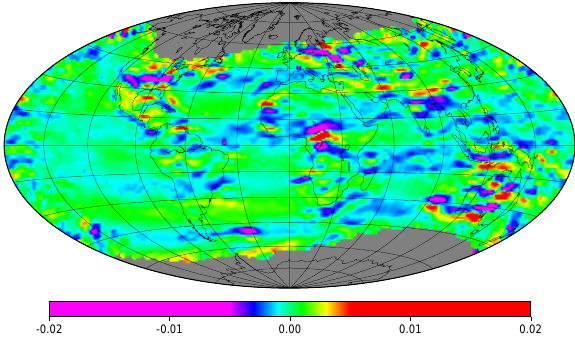
Fig. 2. Along-track second derivative of the crustal field (in nT/s 2 ) Fig. 2. Along track second derivative of the crustal field (in nT/s 2 ) from data in 2001-2004, from data in 2001–2004, longitudinal longitudinal component.